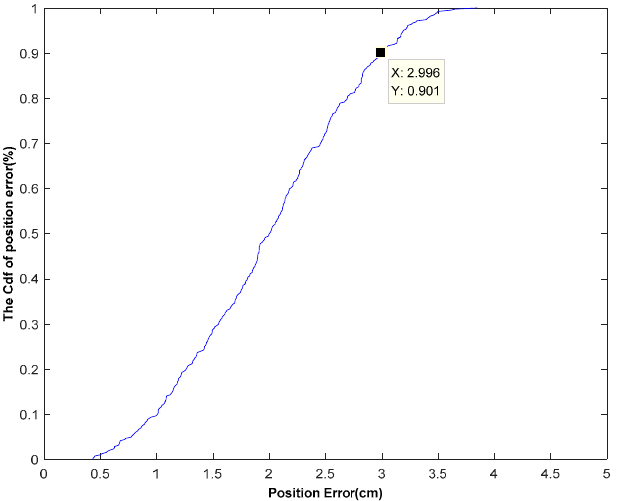
Figure 10. The positioning error varies with height in double-light positioning system.